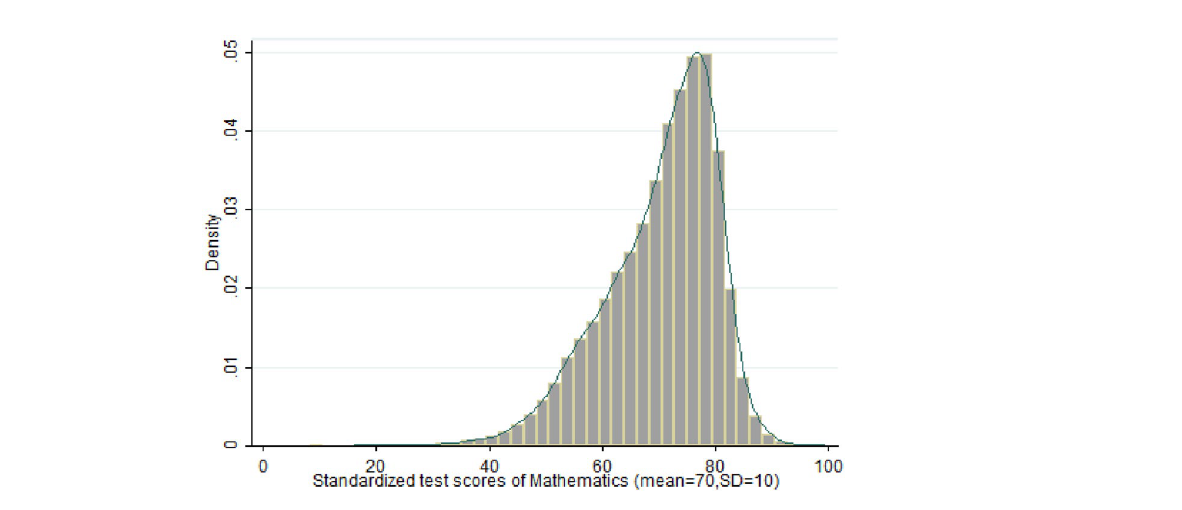
Figure 2. Distribution of mathematics test score.